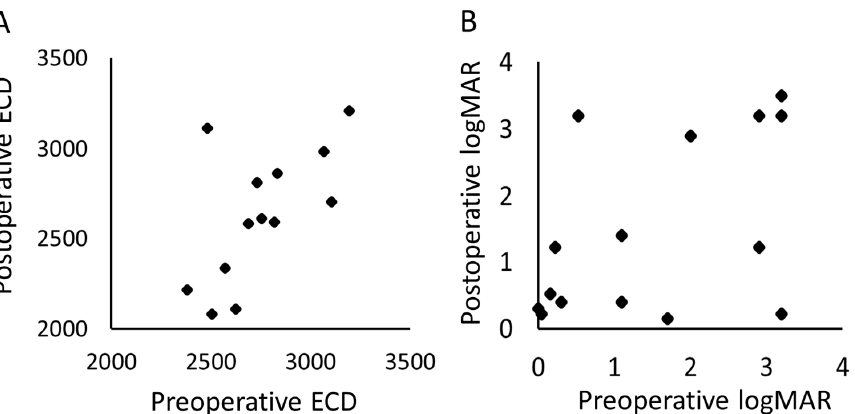
Figure 3. The scatter plots of the preoperative and postoperative ( A ) corneal endothelial cell den- sity and the ( B ) logMAR. ECD, corneal endothelial cell density; logMAR, logarithm of minimal angle resolution.